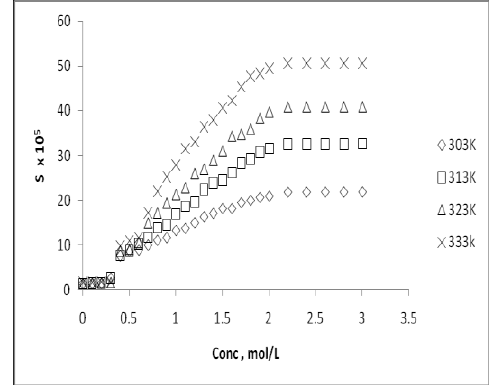
Figure 6. Effect of sodium pseudocumene sulfonate concentration ( C ) on solubility of m- aminoacetophenone.